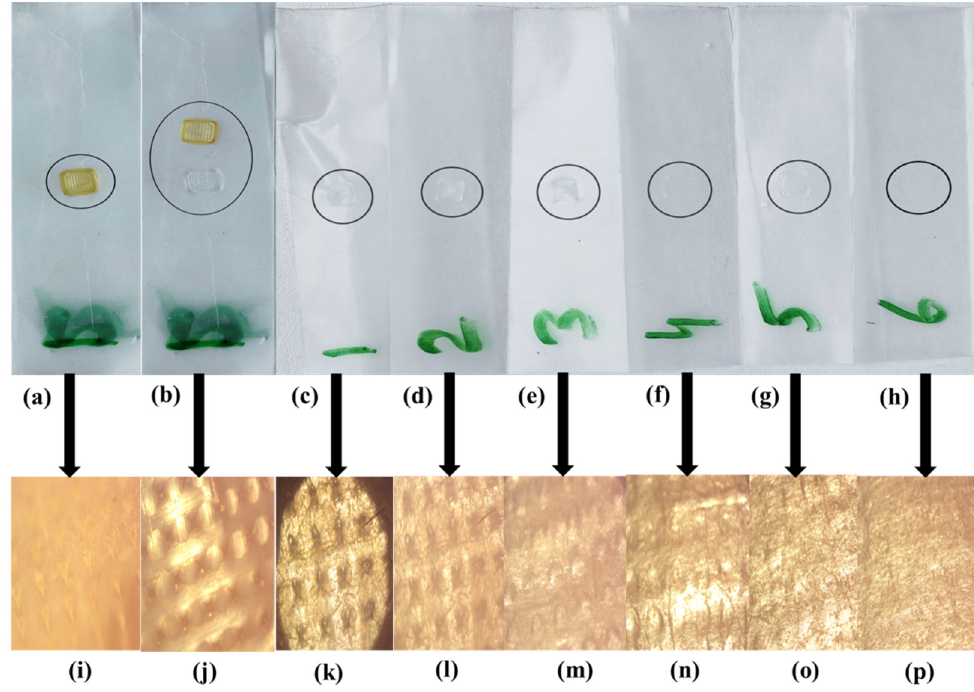
Figure 4. Post insertion microscopic view of the layers, ( a ) microneedle patch applied on paraffin M film 09 layers, ( b ) MNP removed from layers, ( c ) 1st layer of paraffin M film, ( d ) 2nd layer of paraffin M film, ( e ) 3rd layer of paraffin M film, ( f ) 4th layer of paraffin M film, ( g ) 5th layer of paraffin M film, ( h ) 6th layer of paraffin M film, ( i ) sharp microneedles applied on layers, ( j ) after MNP insertion microscopic view, ( k ) microscopic view of 1st layer, ( l ) microscopic view of 2nd layer, ( m ) microscopic view of 3rd layer, ( n ) microscopic view of 4th layer, ( o ) microscopic view of 5th layer, ( p ) microscopic view of 6th layer with absence of microneedle mark. Table 2. Thickness results of Parafilm M layers.